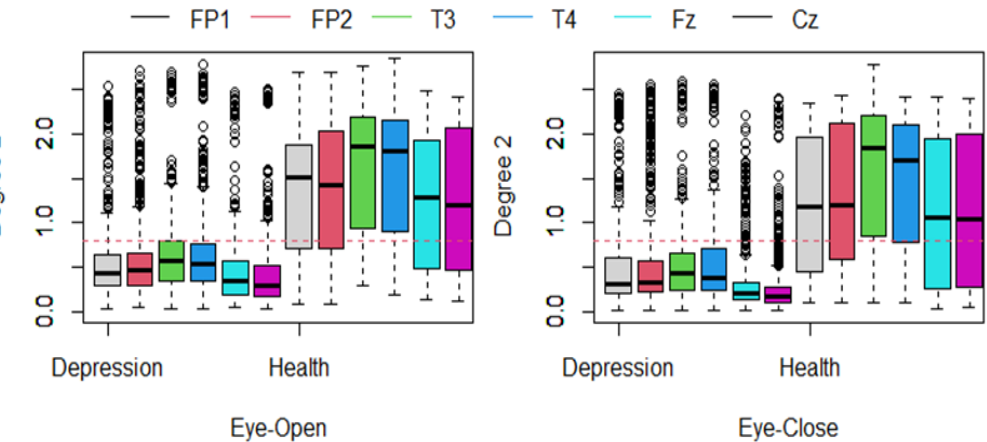
Figure 4. Feature D2 on channels Fp1 (black color), Fp2 (red color), T3 (green color), T4 (blue color), Fz (cyan-blue color), and Cz (fuchsia color), where the depression group has lower D2 values than healthy subjects for both eyes-closed and eyes-open statuses.